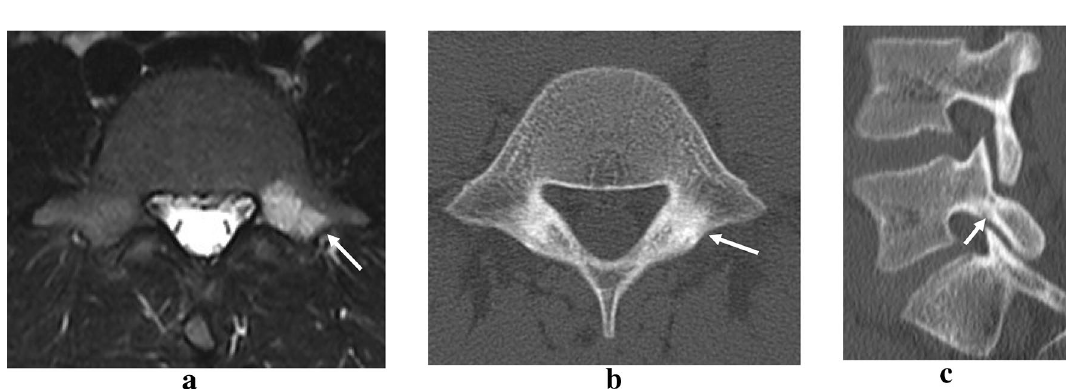
Figure 2. Nineteen weeks after the first examination, the intensity change on MRI disappeared ( a ). The fracture lines disappeared on the axial CT slice ( b ) and there was no obvious worsening of the resorption in the sagittal view ( c , d ).